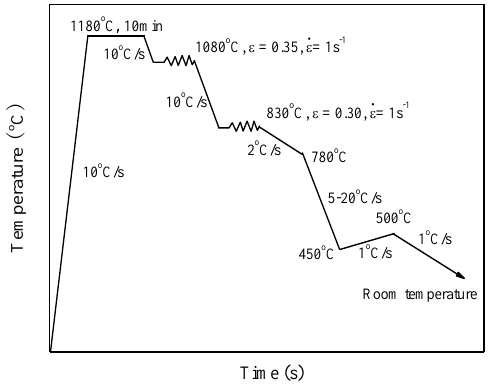
Figure 1. Schematic illustration of simulation schedule for thermal-mechanical controlled processing.